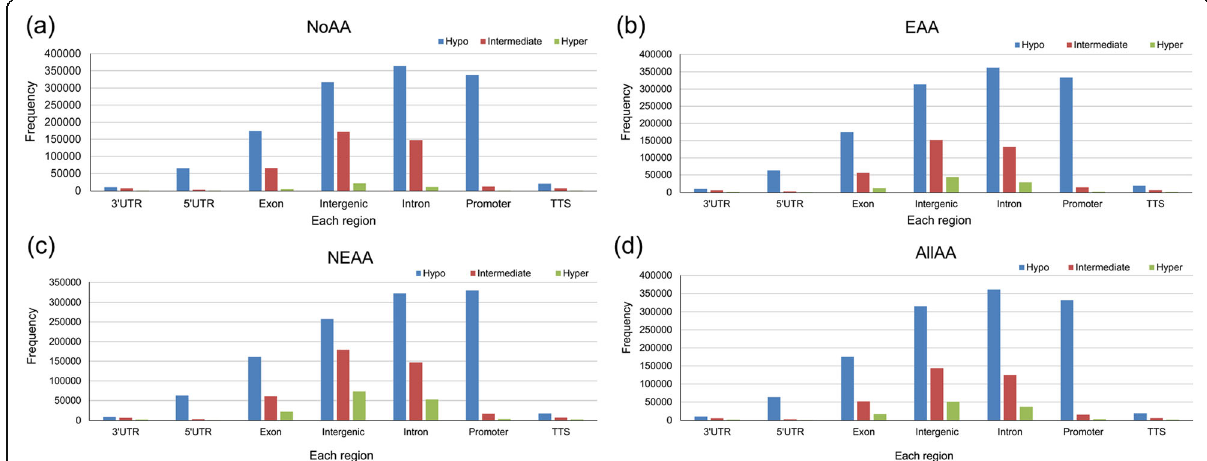
Fig. 4 Number of CpGs in the hypermethylation group, hypomethylation group, and intermediate methylation group shown per region. (> 75%: hypermethylation; < 25%: hypomethylation; other: intermediate group). a NoAA; b EAA; c NEAA; d AllAA; CpG: 5 ′– C – phosphate – G –